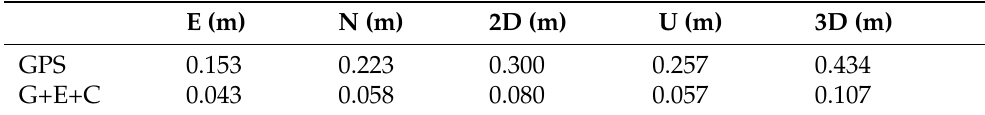
Table 7. Mean RMS values of DF RT–PPP performance in the east, north, horizontal, up, and 3D directions for GPS and multi–GNSS from 10 September to 20 September